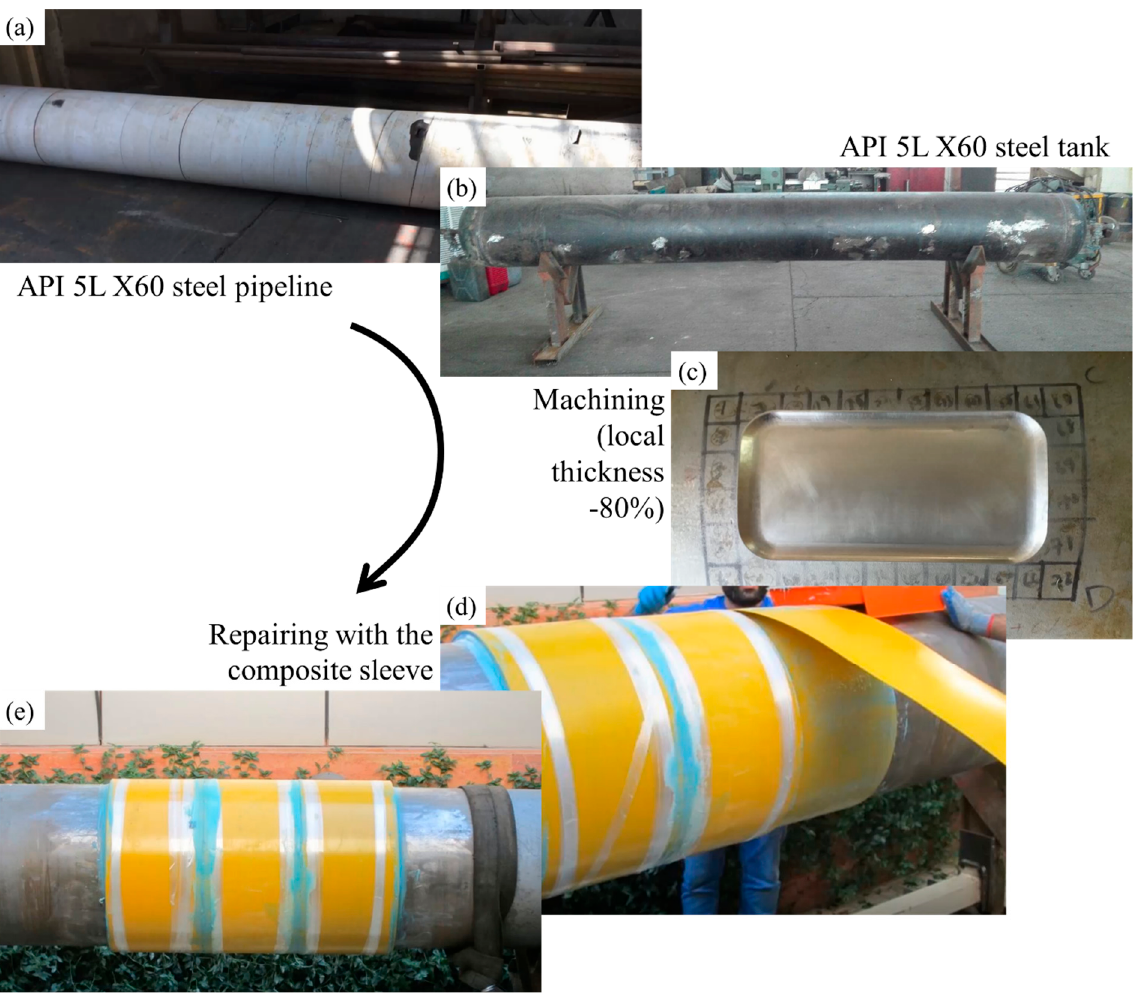
Figure 2. Flow of operations to produce the test article: ( a ) API 5L X60 steel pipeline, ( b ) cut and closed with lateral caps to obtain a tank; ( c ) machined defect and corresponding ( d , e ) repairing process through the composite sleeve.